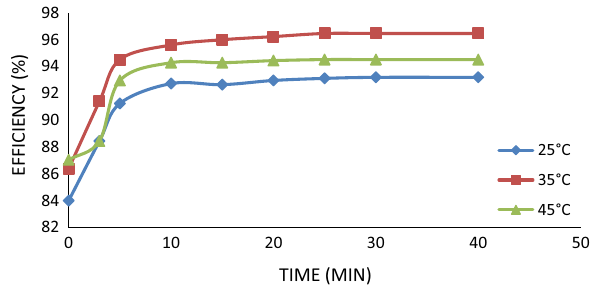
Fig. 7 The plot of temperature effect at 5 g/L dosage, pH 8 and vary- ing temperatures